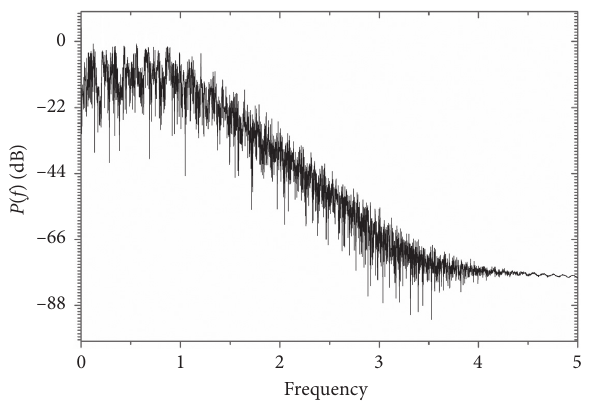
Figure 12: Histogram for 1,000,000 values of the proposed modulo x x x 1 2 3 4